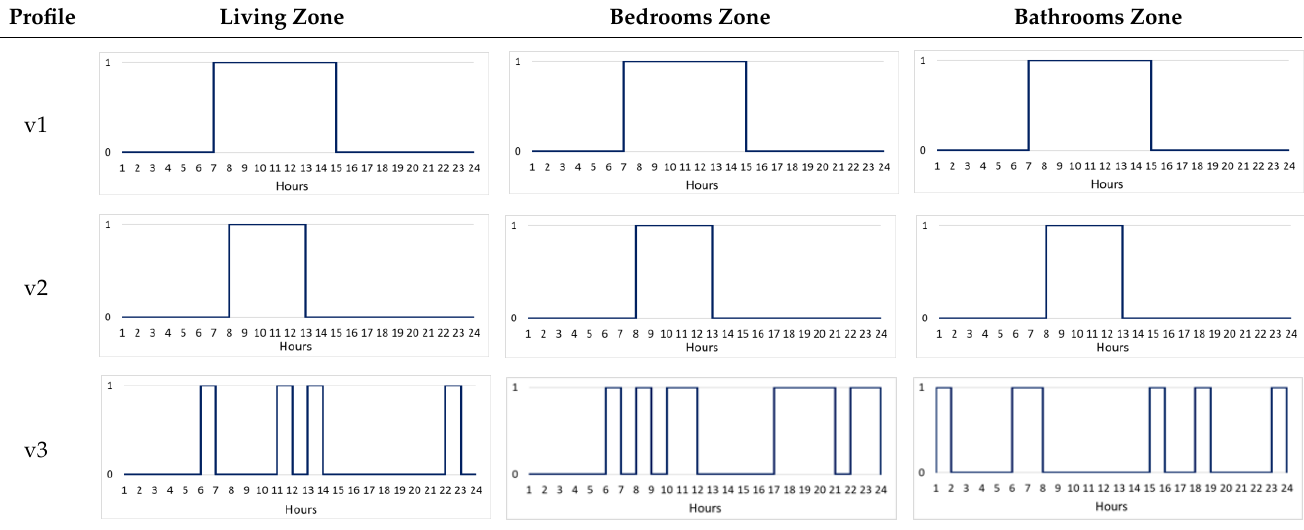
Table 4. Daily cooling schedules (On = 1, Off = 0). Adapted from [33].